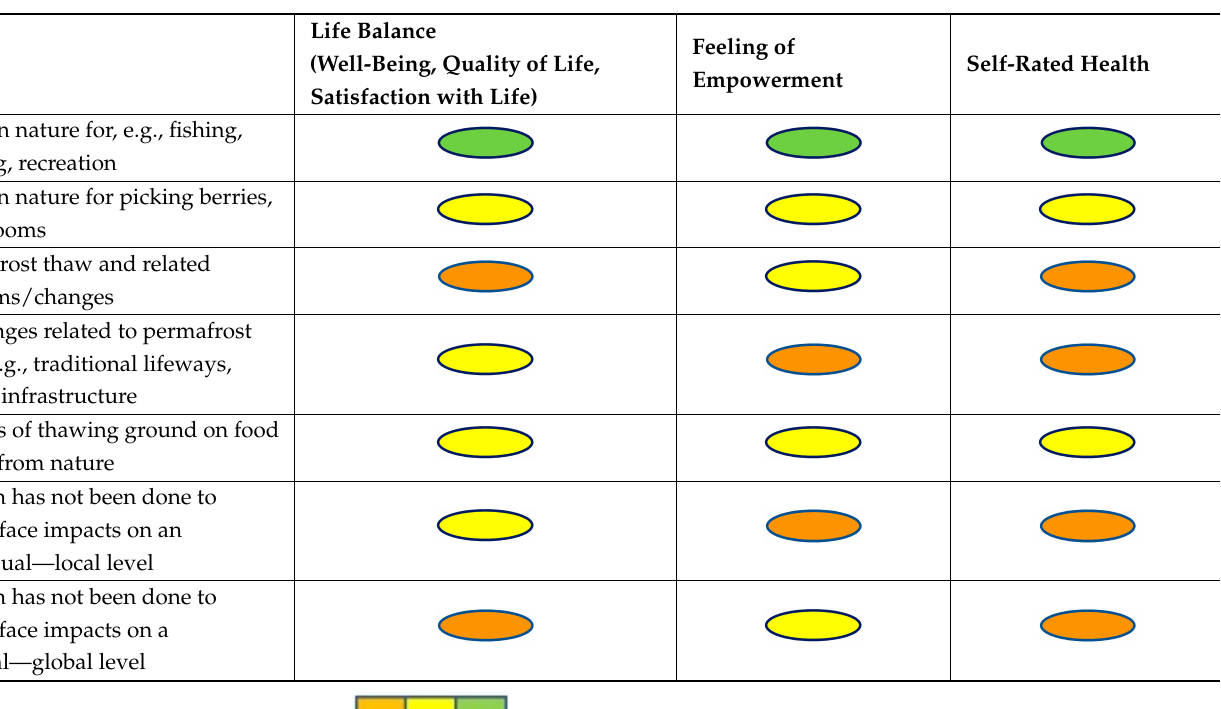
Feeling of Self-Rated Empowerment